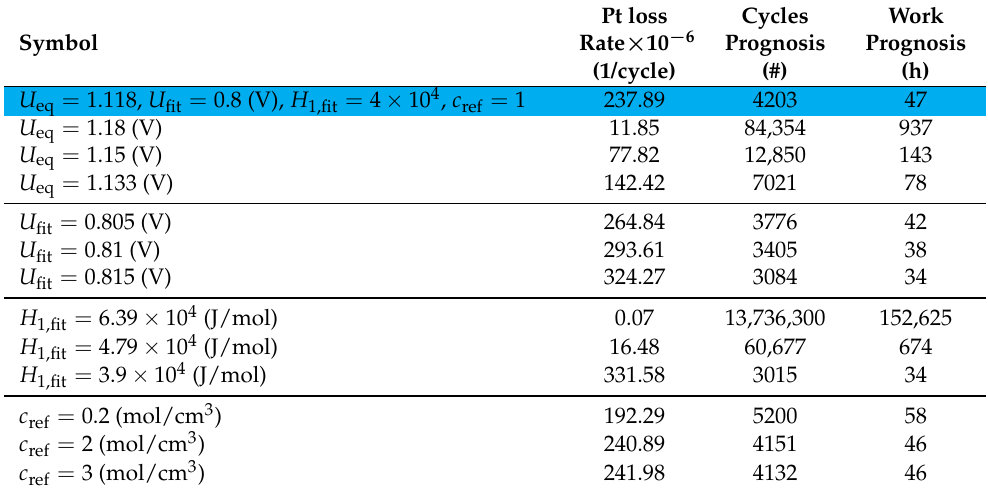
Table 4. Lifetime when fitting: Pt dissolution and oxide formation bulk equilibrium voltage, Pt dissolution activation enthalpy, and reference ion concentration.